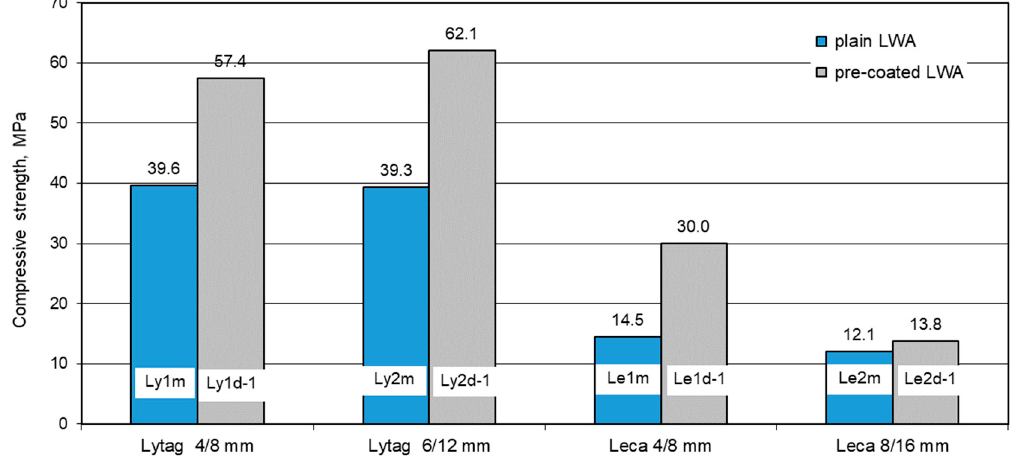
Figure 12. Mean compressive strength of concretes with plain and pre-coated lightweight aggregates.